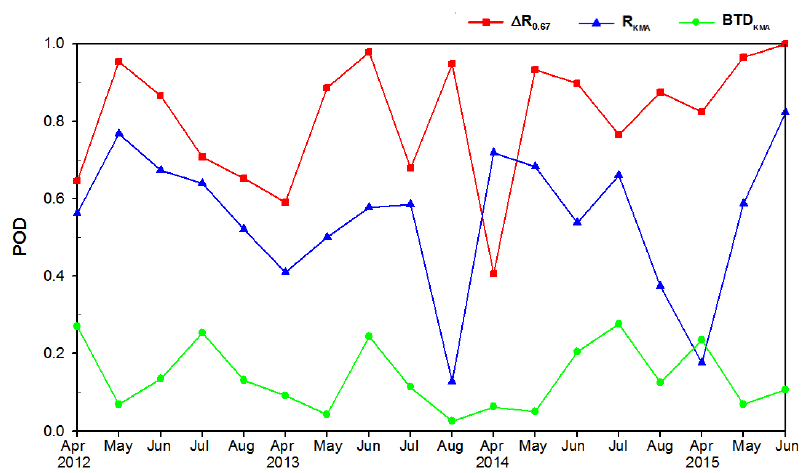
Figure 10. Time series for the monthly fog-detection average values at dawn over South Korea (45 stations). The three series in the figure are shown for the PODs of (i) ΔR 0.67 from the dual satellite observations (red rectangles), (ii) R KMA from COMS (blue triangles), and (iii) BTD KMA from COMS (green circles).